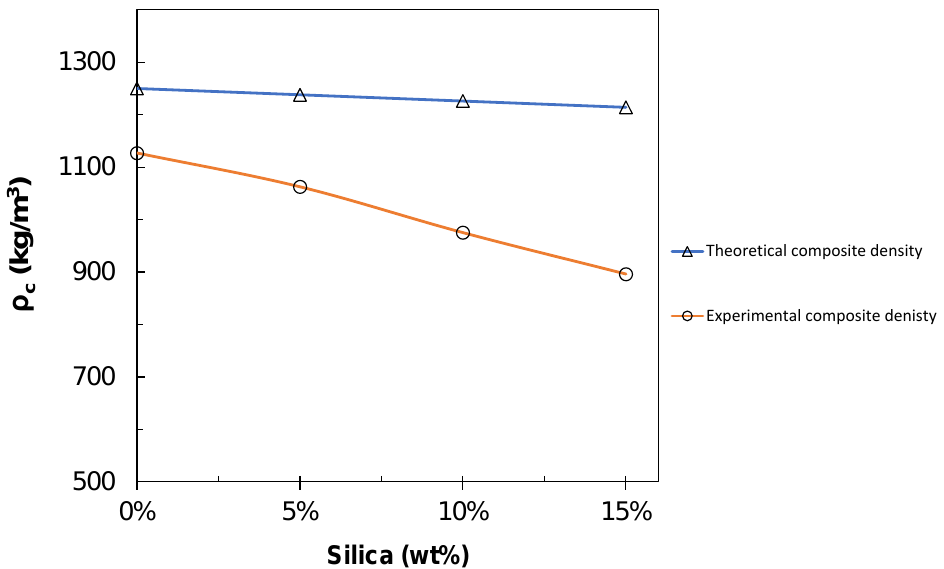
Figure 16. Composite density: Theoretical vs. Experimental.